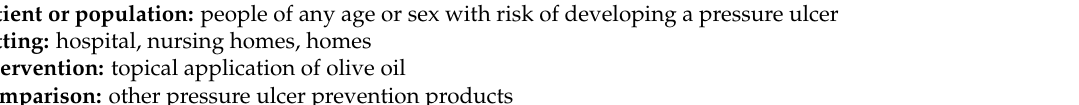
Table 2. Summary of Findings (SoF)